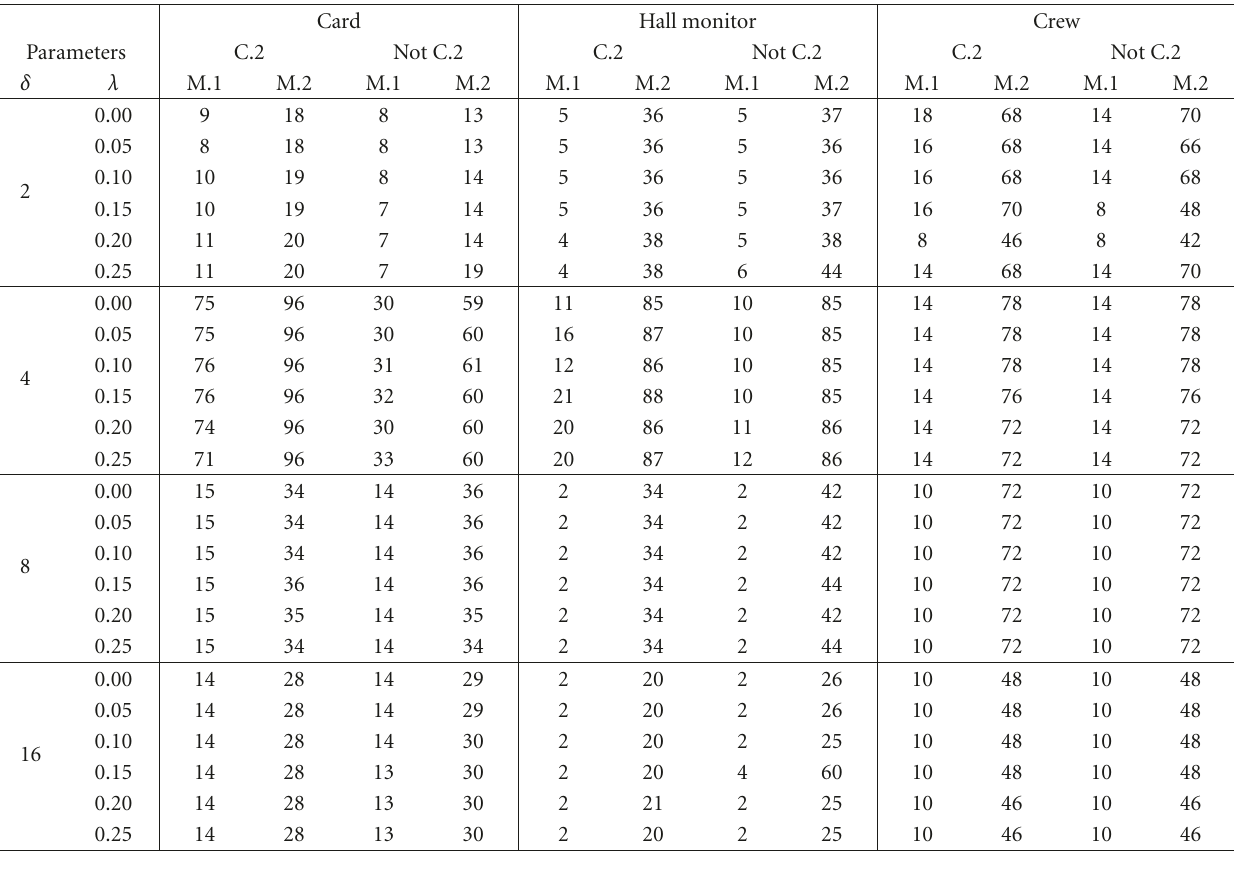
Table 1: Test results